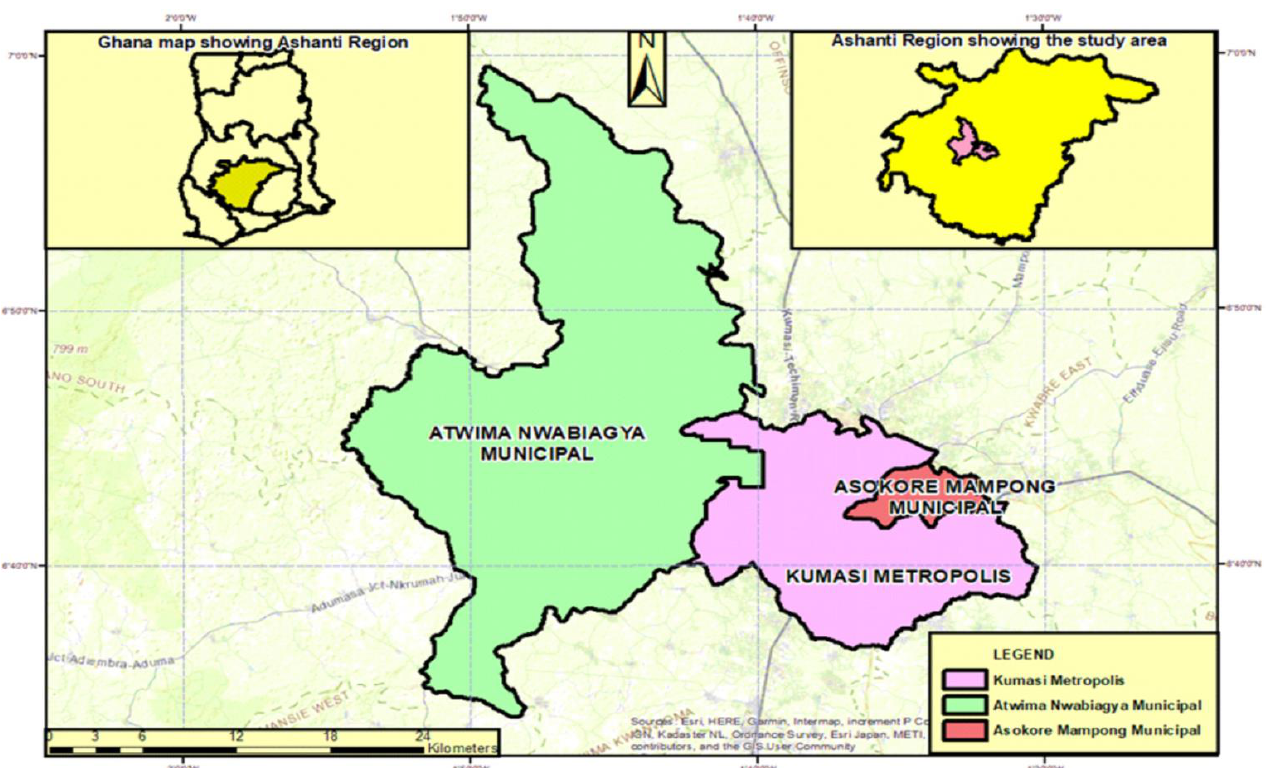
Figure 1. Study Area comprising the Kumasi Metropolitan Assembly, Asokore Mampong Munici-